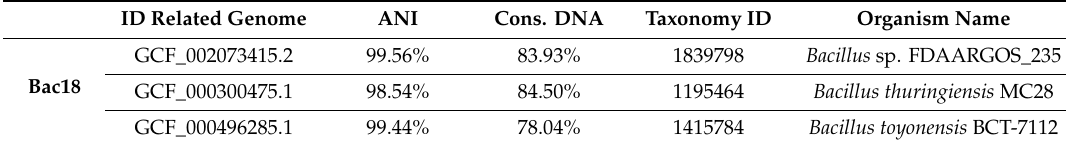
Table 2. Closest reference genome for Bac18 calculated with